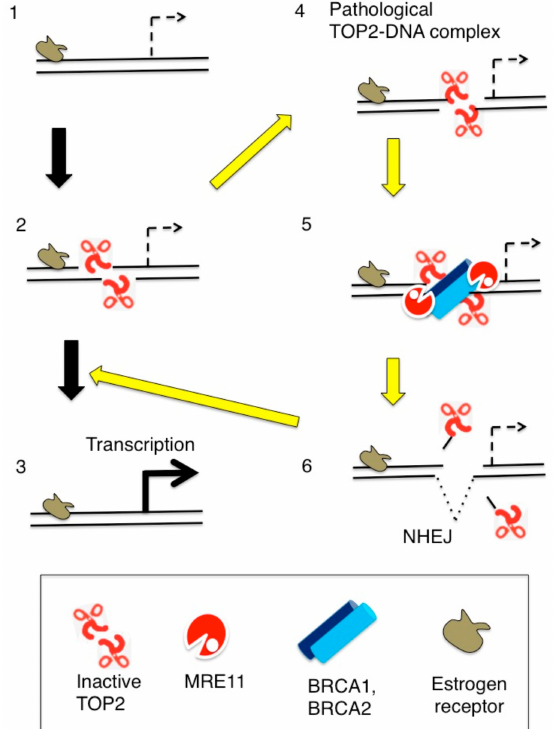
Figure 6. Estrogen-induced TOP2B catalysis causes the formation of stalled TOP2Bccs presumably at transcriptional regulatory sequences. (Step 1) Estrogen receptors (ER) bind at their target genes. (Step 2) TOP2B catalysis at transcriptional regulatory sequences, and (Step 3) estrogens upregulate the transcription of ER-target genes. (Step 4) TOP2B undergoes abortive catalysis generating stalled TOP2Bccs. (Step 5) From the resulting lethal DSBs TOP2B adducts are removed by the coordinated action of BRCA1, BRCA2, and Mre11. (Step 6) NHEJ seals DSBs leading a cycle of TOP2B-mediated catalyses (Step